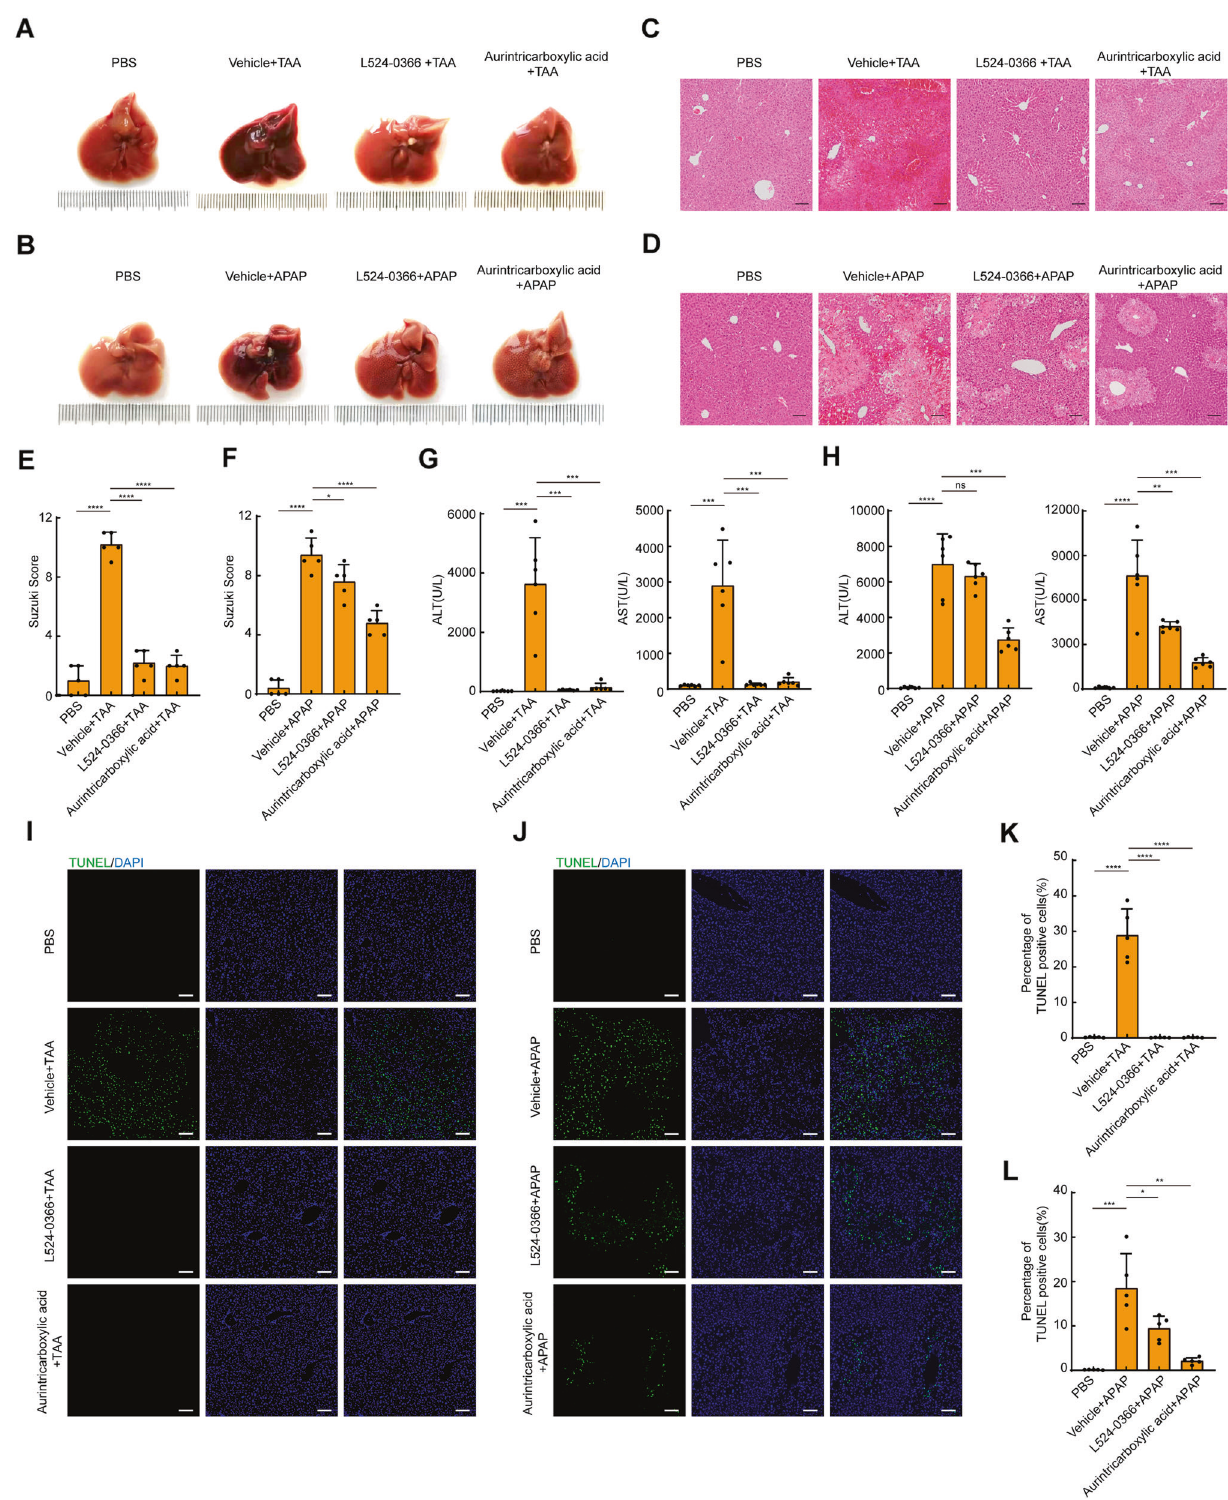
Fig. 2 Inhibitors of TWEAK/Tnfrsf12a axis attenuates ALF induced by TAA or APAP. A , B Representative macroscopic appearance of livers at 24 h following TAA or APAP treatment in the presence or absence of TWEAK/Tnfrsf12a axis inhibitors. C , D Representative H&E-stained liver sections. Scale bars, 100 μ m. E , F Suzuki score of H&E-stained liver sections ( n = 5; mean ± s.d.). P values were determined by Student ’ s t test (* P < 0.05; **** P < 0.0001). G , H Serum levels of ALT and AST(U/L) ( n = 6; mean ± s.d.). P values were determined by Student ’ s t test (** P < 0.01; *** P < 0.001; **** P < 0.0001; ns, not signi fi cant). I , J Representative TUNEL-stained liver sections. Scale bars, 100 μ m. K , L Percentage of TUNEL positive cells in liver sections ( n = 5; mean ± s.d.). P values were determined by Student ’ s t test (* P < 0.05; ** P < 0.01; *** P < 0.001; **** P < 0.0001). All experiments were repeated at least two